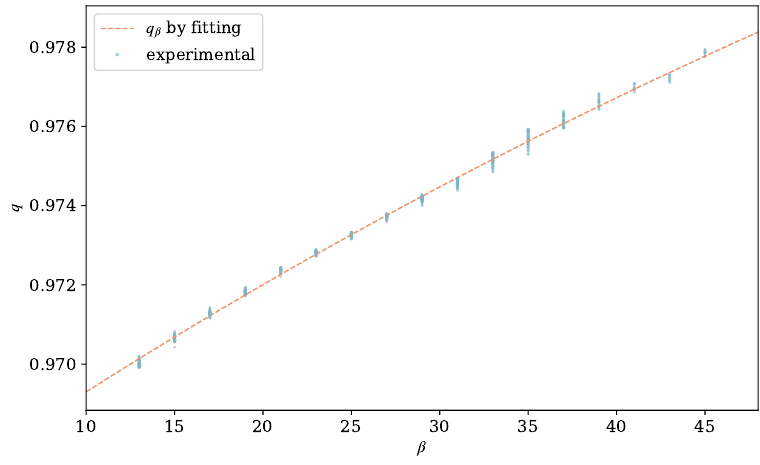
Figure 5. The relation between q and BKZ blocksize β .